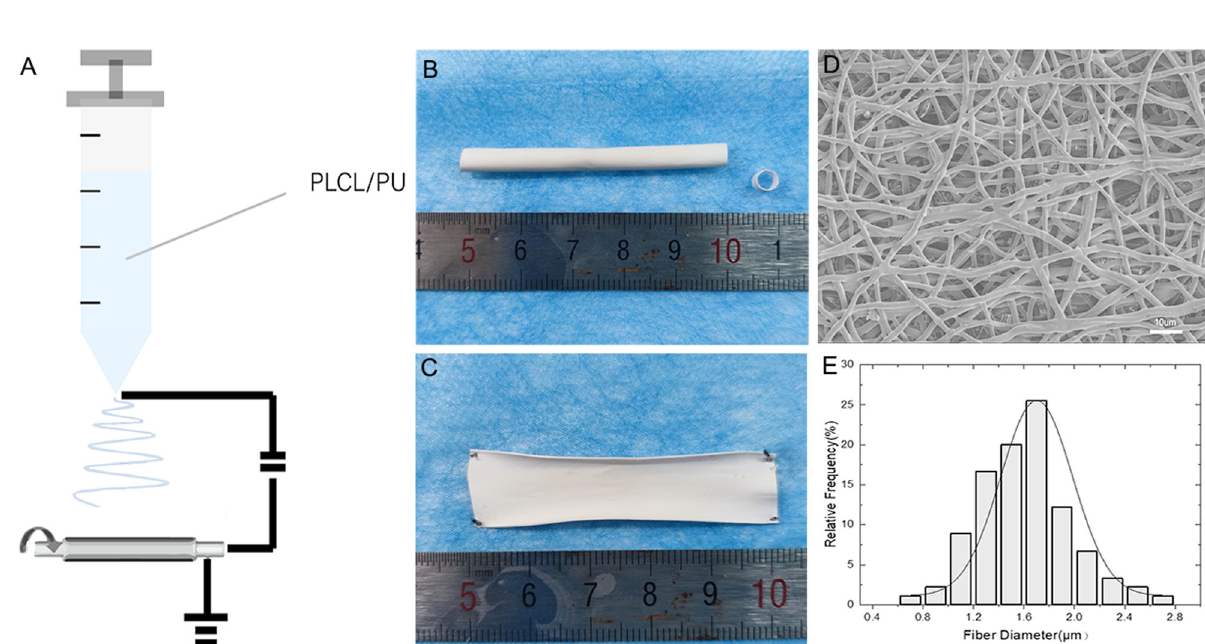
SEM image of the electrospinning fi bers ( D ). The fi ber diameter dis- tribution of the vascular scaffold ( E )